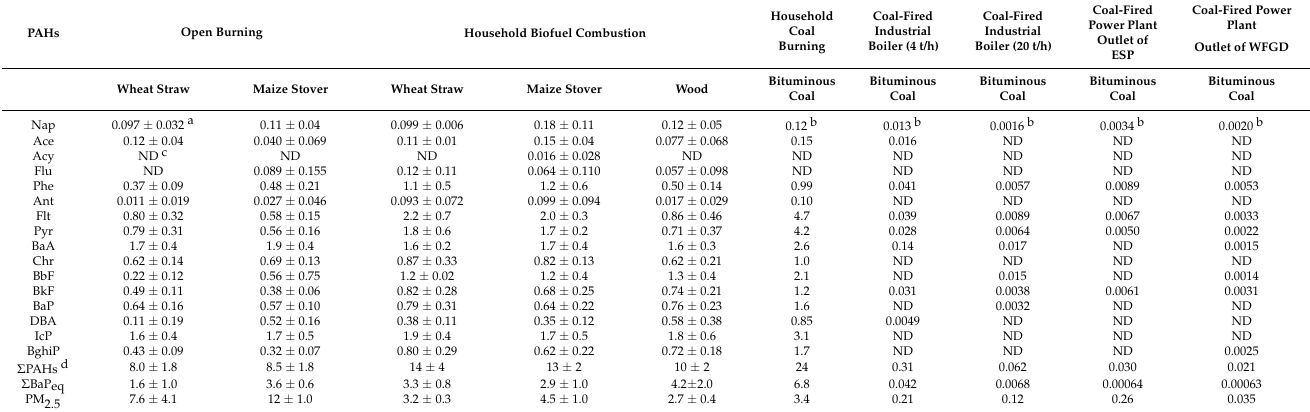
a The results are given as average emission factor and standard deviation. b Single measurement results or combined analysis of several sampling filters, c Not detected or less than background level. d Sum of emission factor of 16